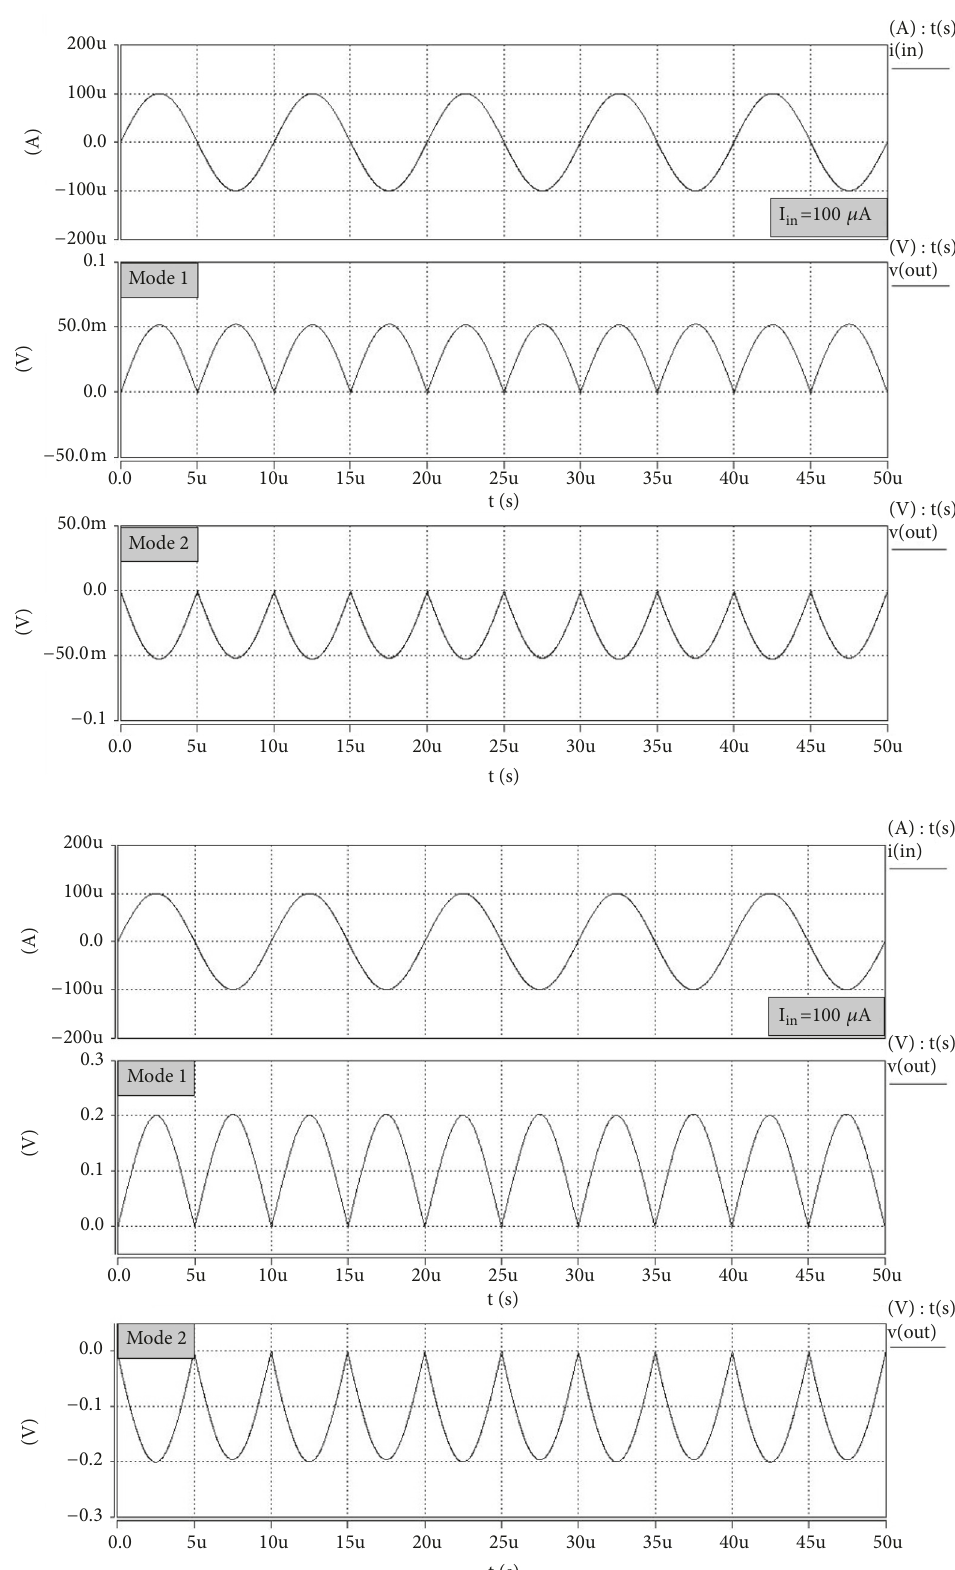
Figure 15: Simulation results of the tunable rectified output amplitude for the circuit (Figure